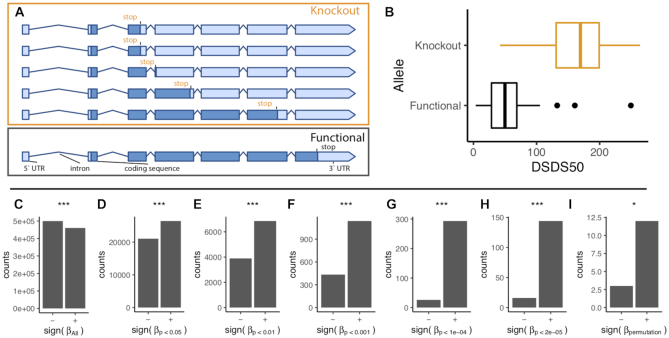
KO-trait association detected between AT1G57570 and days of seed dry storage required to reach 50% germination (DSDS50) reported by (1). (A) Predicted natural knockout alleles identified in (35). (B) Boxplots showing DSDS50 for accessions with functional (black) versus KO alleles (orange) of AT1G57570. The vertical lines mark the medians while the boxes indicate the interquartile ranges (IQR) between the 25th and 75th quantiles, and the whiskers mark no >1.5 IQR. More broadly, there was a tendency for significant KO allele associations to have positive beta coefficients. Bar plots show the relative frequency of positive and negative beta (β) coefficients across all traits tested (***P < 2 × 10−16, *P < 0.05, Chi-squared tests), for (C) all associations regardless of significance and for associations subsetted by varying significance thresholds: (D) P < 0.05, (E) P < 0.01, (F) P < 0.001, (G) P < 1 × 10−4, (H) P < 2.4 × 10−5 (threshold after Bonferroni correction) (I) permutation-based significance thresholds.